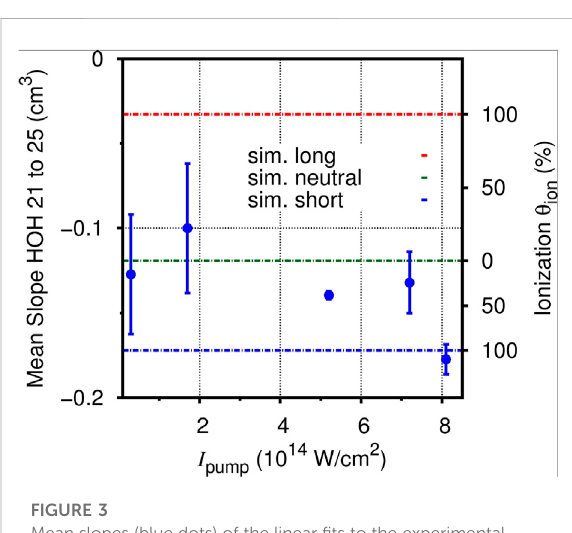
FIGURE 3 Mean slopes (blue dots) of the linear fi ts to the experimental data on orders 21 – 25 as a function of the intensity of the pump pulse. The horizontal lines indicate the slopes obtained from the simulations of [36] for the long (red) and short (blue) trajectories in an ionic background medium and the case of a neutral background medium (green). The comparison with the simulation allows the conversion of the mean slopes into the amount of ionization within the